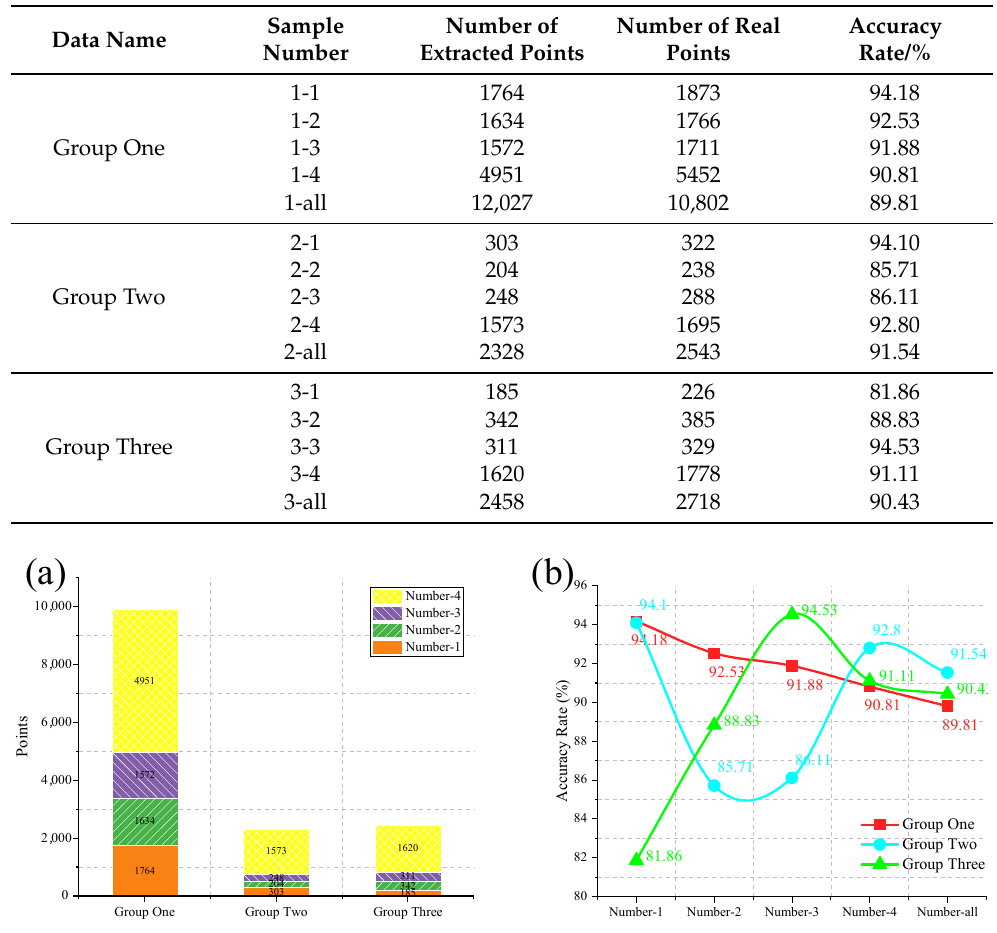
Figure 7. Data analysis chart: ( a ) represents the proportion of each sample within each group; ( b ) shows the change in extraction accuracy in each